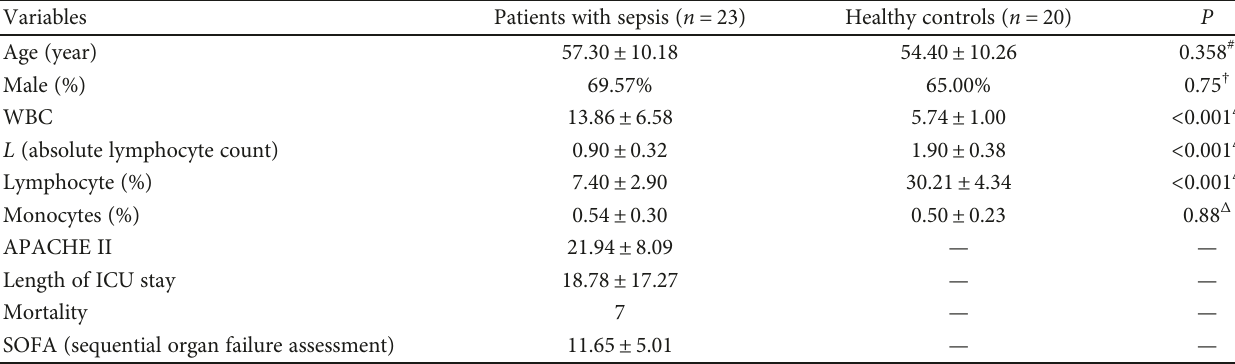
Table 1: The demographic and clinical characteristics of